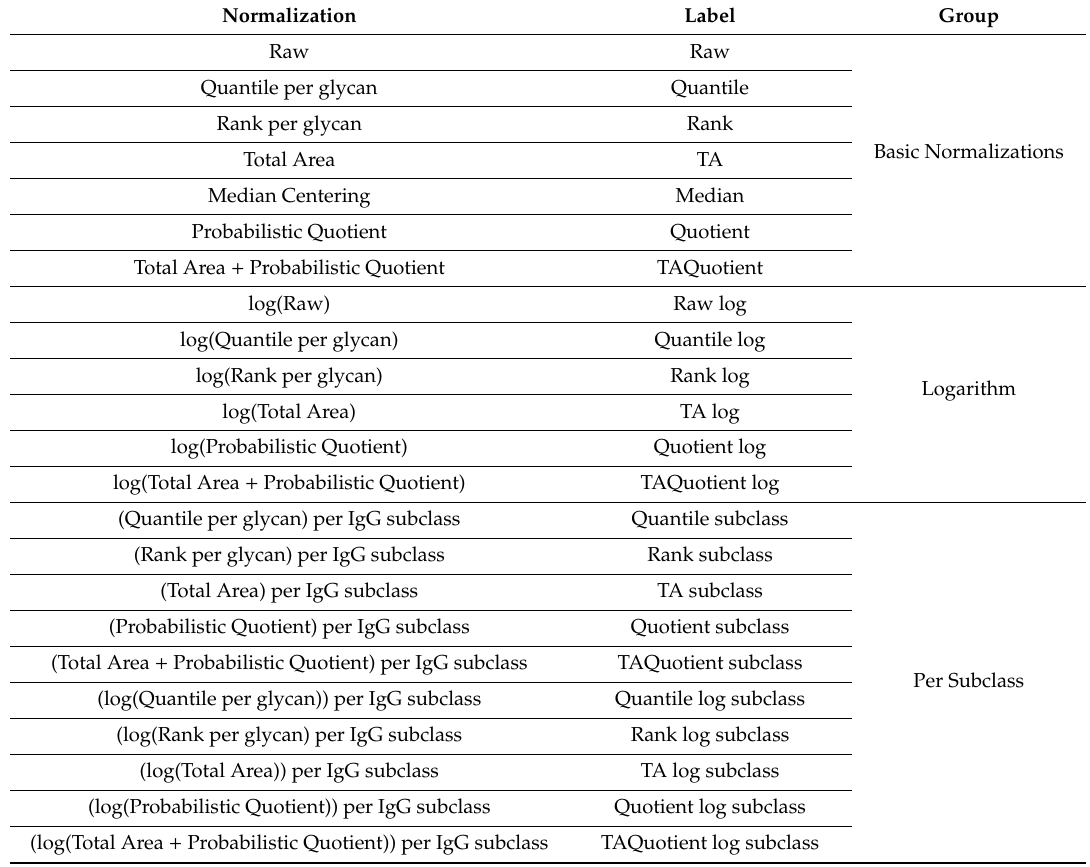
Table 2. Evaluated normalization